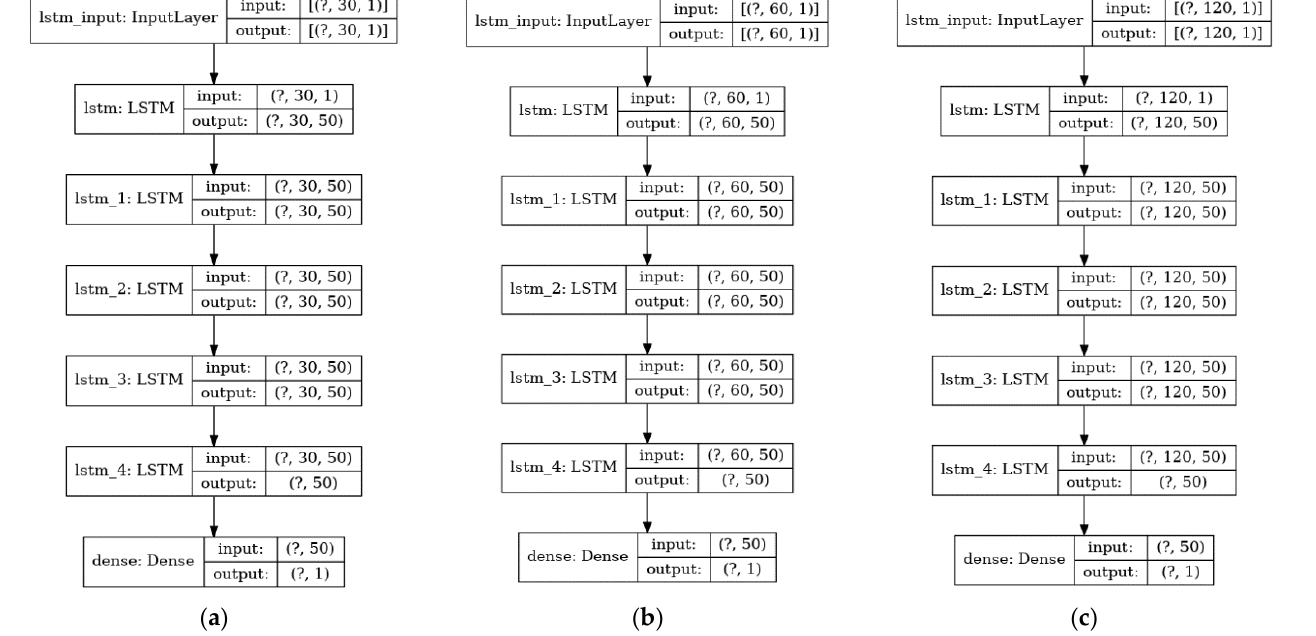
Figure 4. Long Short-term Memory (LSTM) models with ( a ) 30 timesteps, ( b ) 60 timesteps, and ( c ) 120 timesteps.